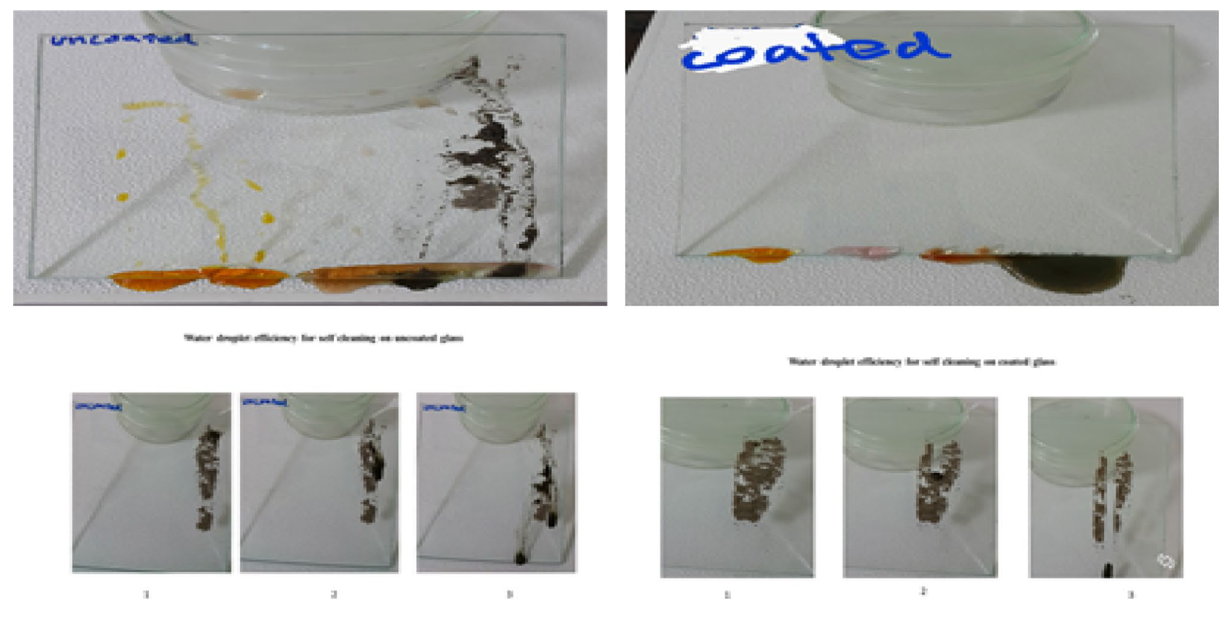
Figure 14. Self-cleaning efficiency of